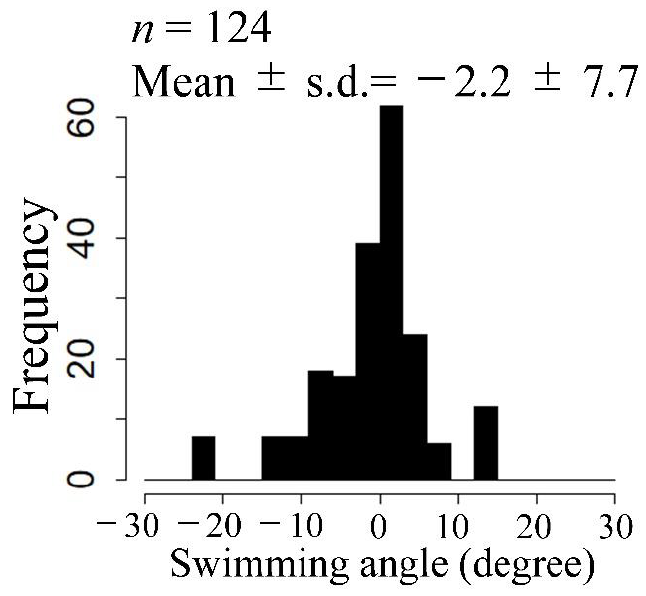
Figure 4. Histogram of swimming angle at 120 kHz. n shows the number of swimming tracks.